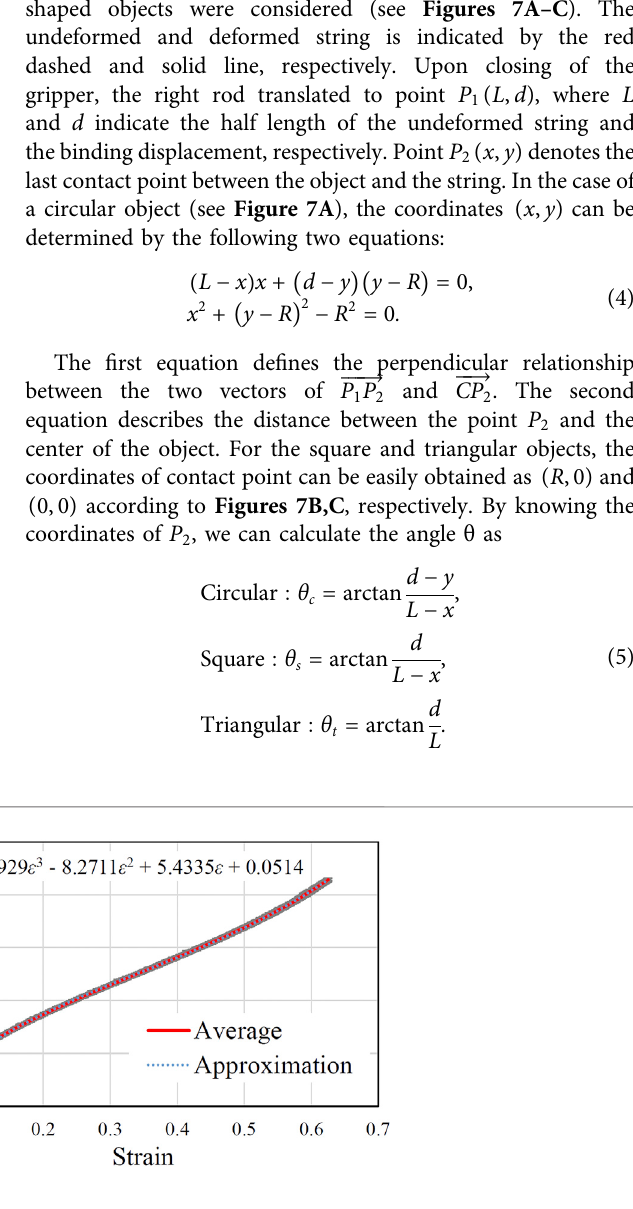
FIGURE6|(A) Experimentalsetupforthe fl exiblestringcharacterization. (B) Relationshipbetweenthestrainandthetensionforce.Theshadedregionindicatesthe standard deviation from fi ve trials.